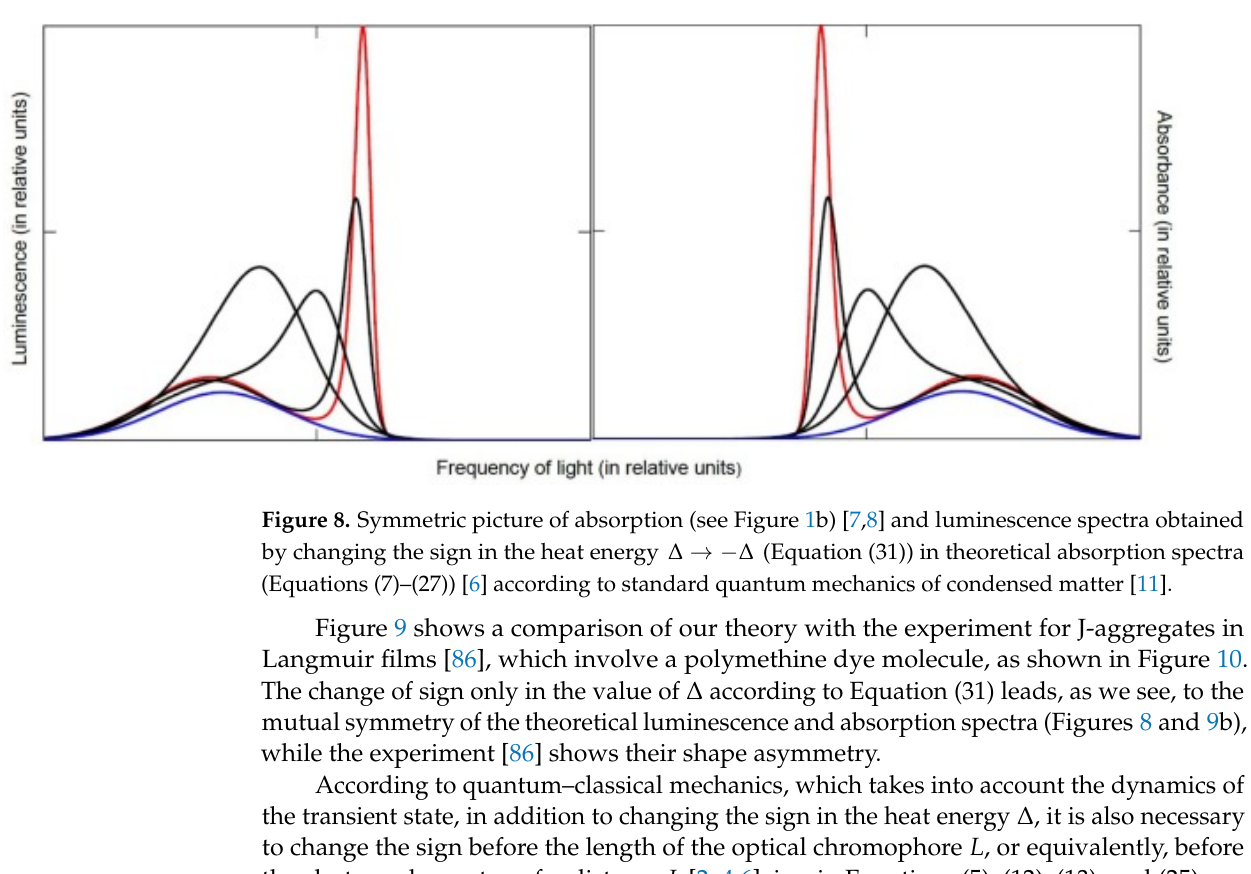
Figure 9. Comparison of theory with experiment for J-aggregates in Langmuir films. ( a ) Absorption and fluorescence J-bands of a C18S4 monolayer obtained in a Langmuir film [86]. The characteristics of photoluminescence (PL) spectrum: a peak at 590 nm, a FWHM = 18 nm and a Stokes shift of 1 nm [86]. ( b ) Theoretical absorption and fluorescence J-bands [6], fitted to the experimental data [86] (see ( a )). The absorption J-band is computed from Equations (7)–(27), where the “J-aggregate + environ- ment” system parameters are